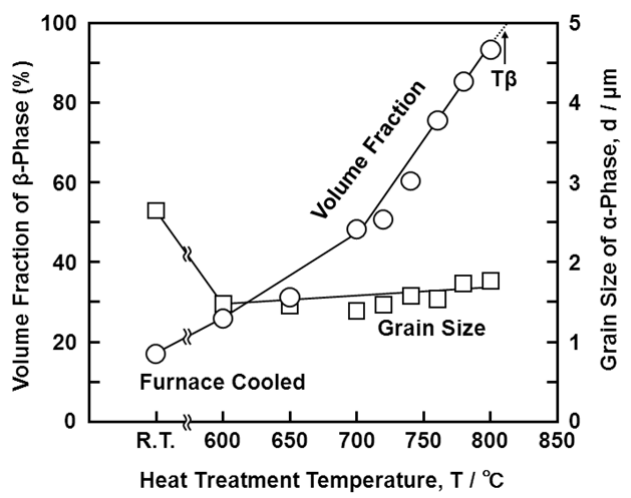
Figure 5. Effects of solution treatment temperature on volume fraction of β -phase and grain size of α -phase of Ti-15Zr-4Nb-4Ta alloy